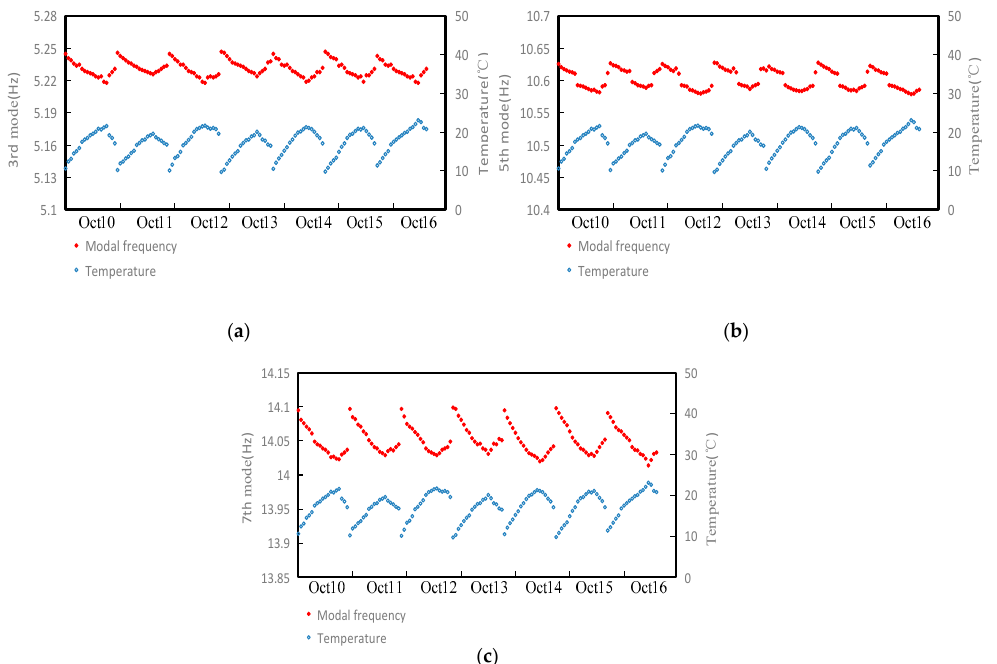
Figure 11. Curves of ambient temperature and modal frequency: ( a ) curve of ambient temperature and 3rd modal frequency; ( b ) curve of ambient temperature and 5th modal frequency; ( c ) curve of ambient temperature and 7th modal frequency.